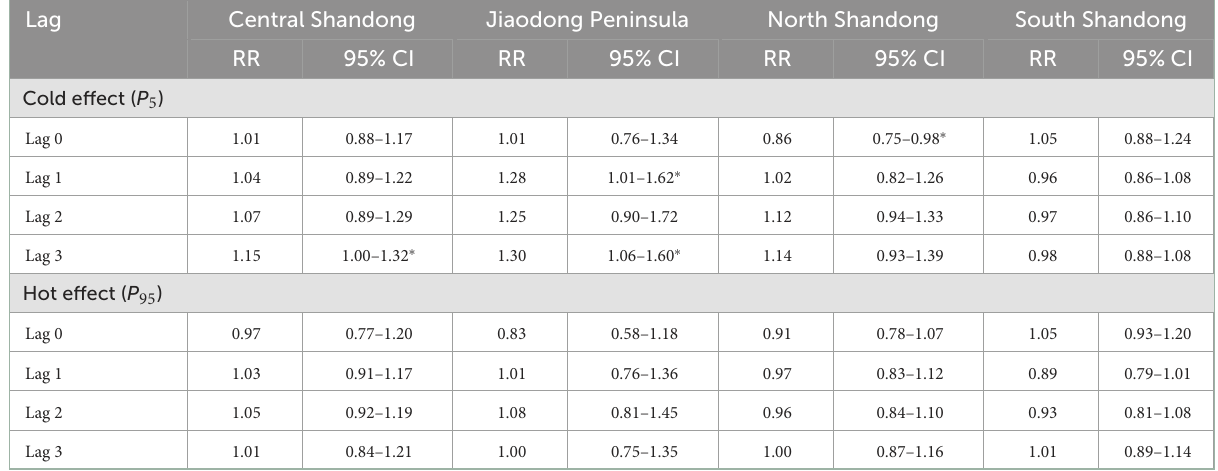
TABLE 2 The cold and hot effects with reference to temperature of 50th on influenza-like illness in Shandong, China. Lag